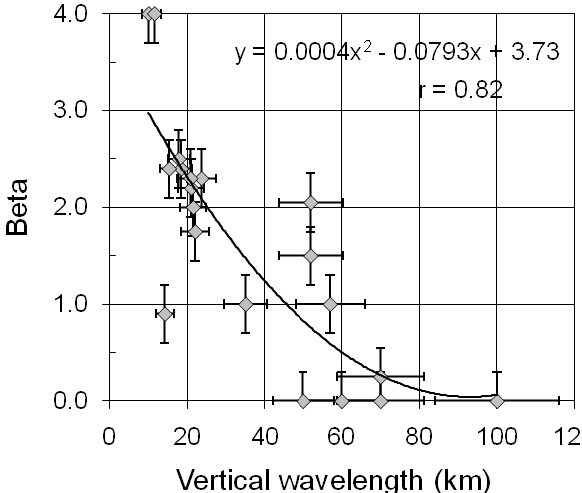
Fig. 6. Wave damping rate as a function of the vertical wavelength for each wave event observed, based on the Fig. 6a by Vargas et al. (2007). The fitted line is polynomial fitting and “ r ” indicates the correlation coefficient.